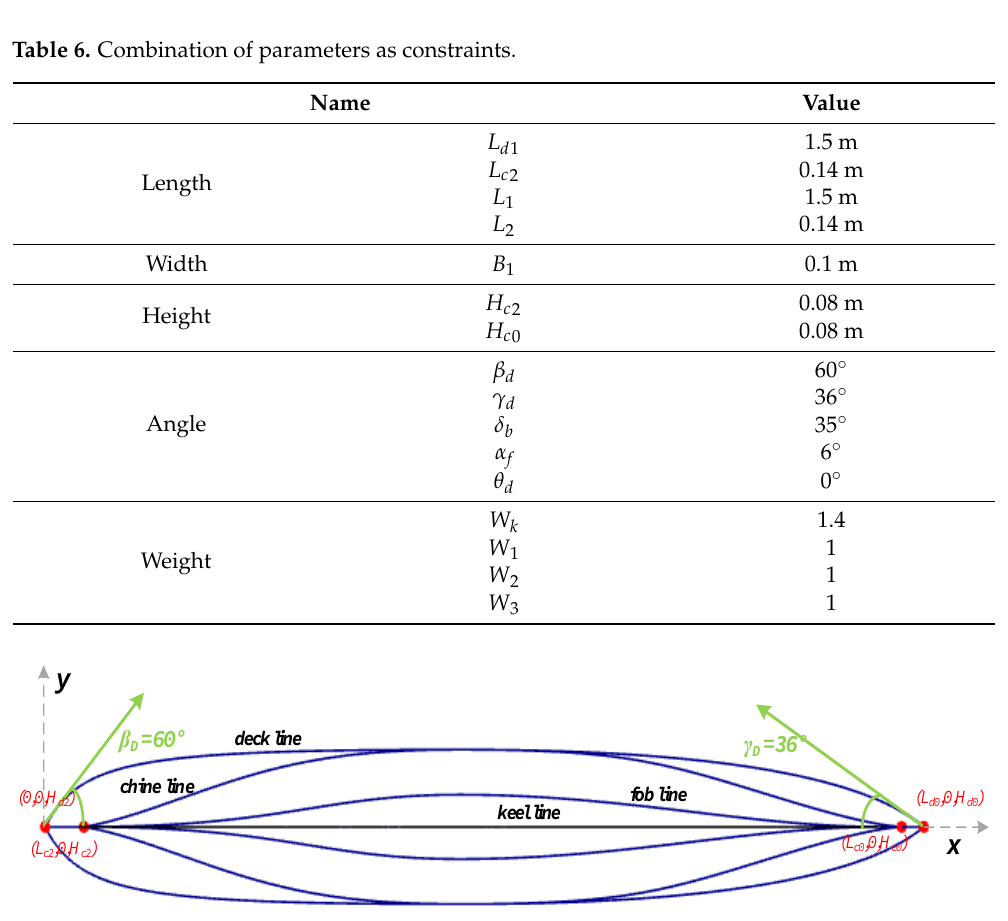
Figure 21. Hull profile under constraint conditions. Table 7. Boundaries of design variables used for sample Table 6. Combination of parameters as constraints.